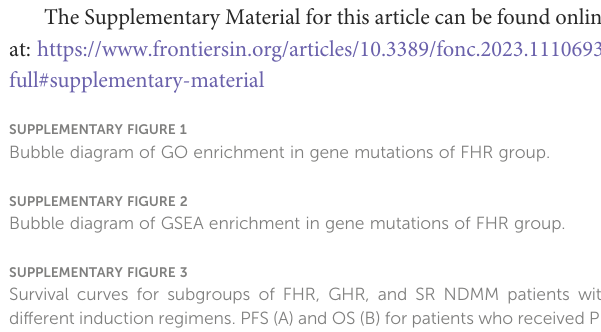
SUPPLEMENTARY FIGURE 1 Bubble diagram of GO enrichment in gene mutations of FHR group. SUPPLEMENTARY FIGURE 2 Bubble diagram of GSEA enrichment in gene mutations of FHR group. SUPPLEMENTARY FIGURE 3 Survival curves for subgroups of FHR, GHR, and SR NDMM patients with different induction regimens. PFS (A) and OS (B) for patients who received PIs +IMiDs-based regimens; PFS (C) and OS (D) for patients who received PIs- based